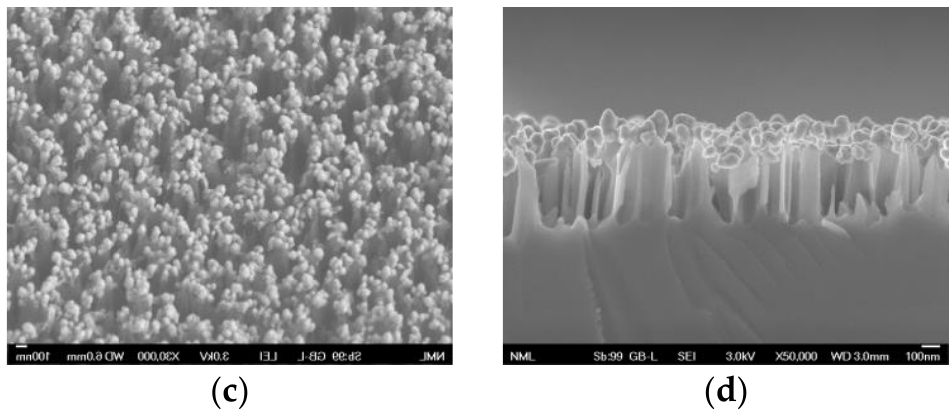
Figure 1. SEM images of SiNWs prior to (( a ): top view (scale bar 1 μ m, magnification ×10,000); ( b ): cross-section (scale bar 100 nm, magnification ×100,000)) and after growth of silver aggregates on the surface of SiNWs (( c ): top view (scale bar 100 nm, magnification ×30,000); ( d ): cross-section (scale bar 100 nm, magnification ×50,000)). The Ag aggregates grow mainly at the tips of the SiNWs. In Figure S1, the UV-vis absorption spectra of bare SiNWs and SiNWs/Ag nanopar- ticles are presented. The absorption spectra were obtained from the respective diffuse re- flection spectra [33,34] by applying the standard Kubelka – Munk method [58]. As shown, the absorption of substrates with bare SiNWs is stronger at wavelengths greater than 350 nm (VIS light), while substrates with Ag nanoparticles on top have significantly higher absorption at UV.